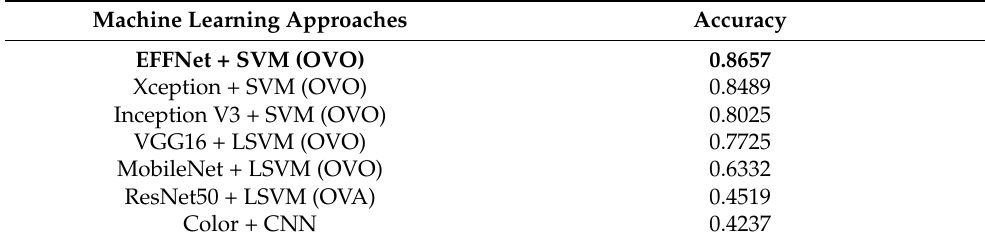
Table 19. The highest accuracy based on feature representation for VIREO-Food172 Dataset.